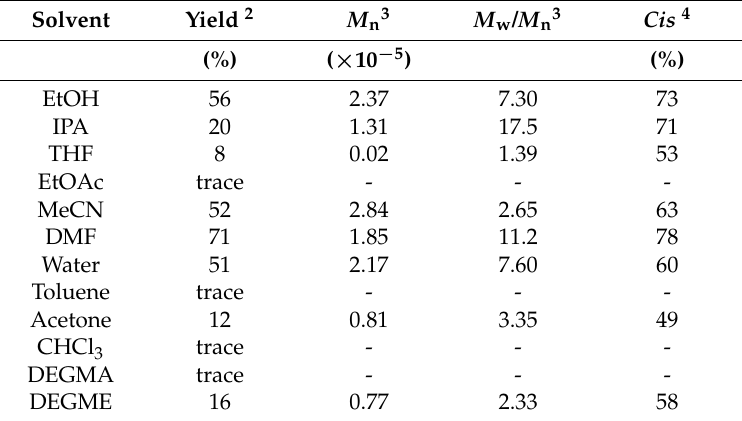
Table 2. Synthesis of POP(2) using a [Rh(nbd)Cl] 2 catalyst in various solvents 1